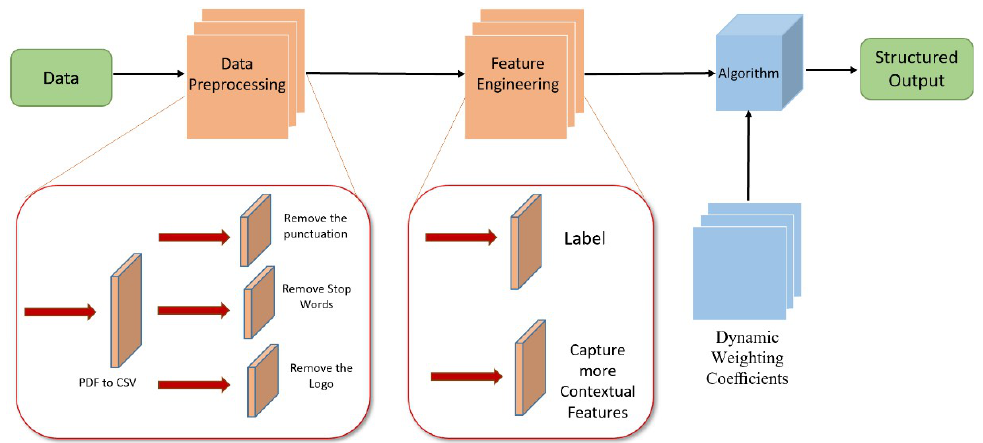
Figure 1. The framework of Dynamic Weighting Structural analysis (DWSA). The DWSA framework mainly includes three parts: data pre-processing, feature engineering, and structural